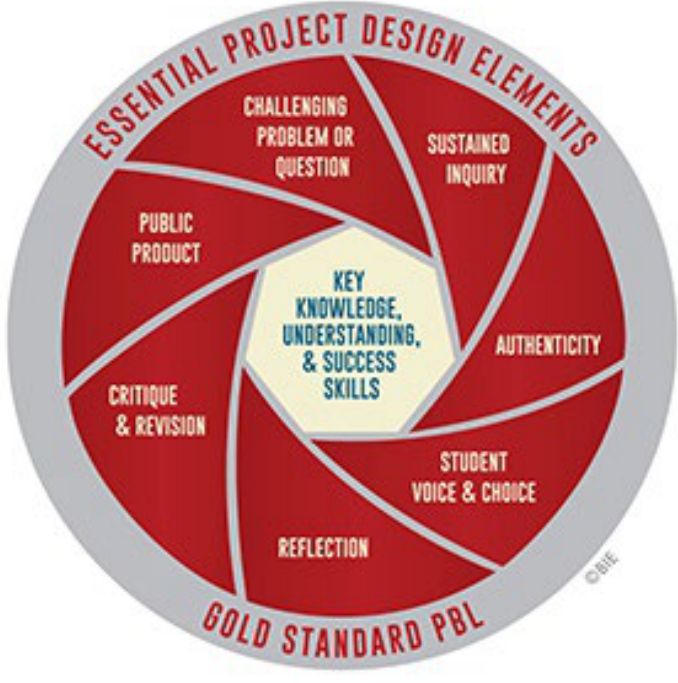
Source: Adapted from Mergendoller, Boss & Larmer,